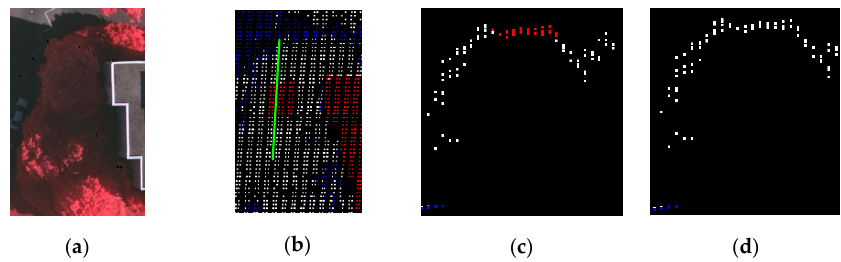
Figure 7. Two trees with dense leaves. ( a ) Orthophoto; ( b ) Point data. The approximate location of profile is indicated by the green line; ( c ) Profile before consistency constraint; ( d ) Profile after consistency constraint.